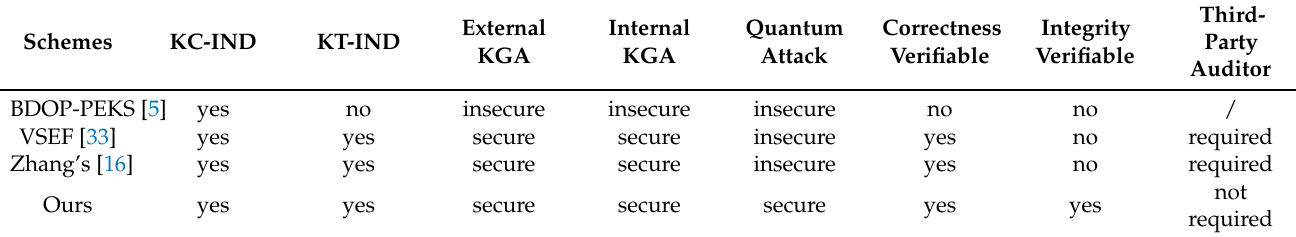
Table 1. Security